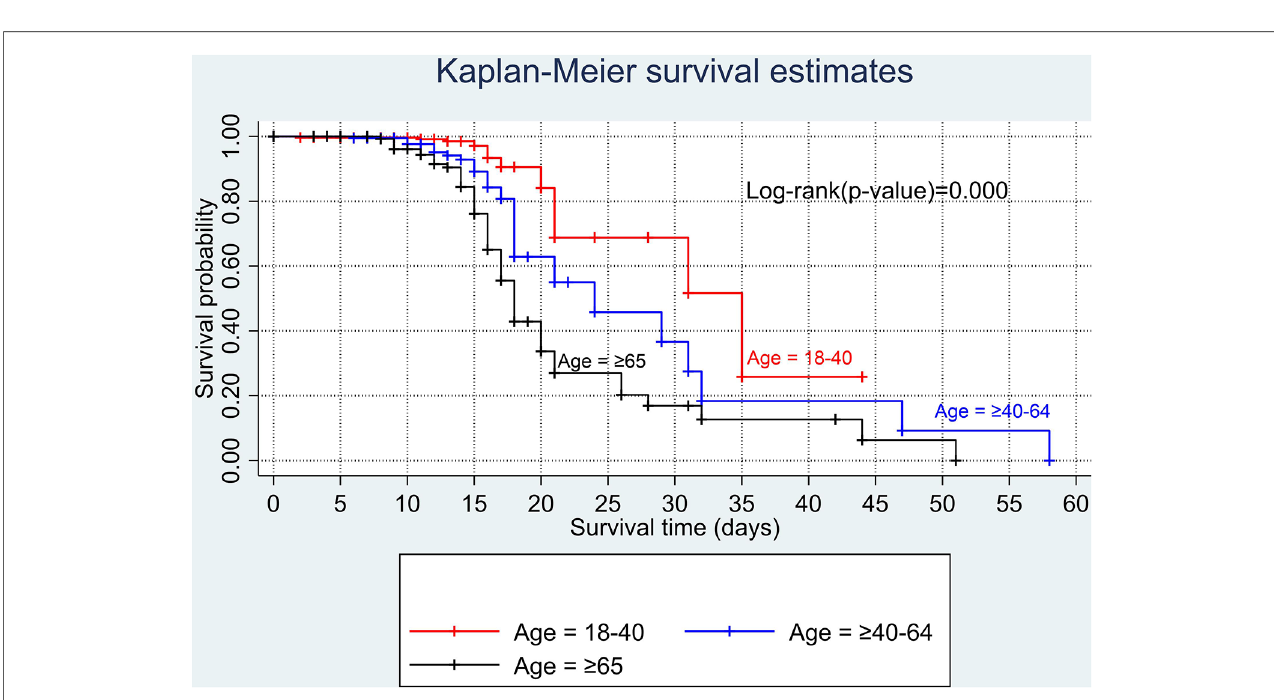
FIGURE 2 Kaplan – Meier survival curve by age categories among adult COVID-19 patients.